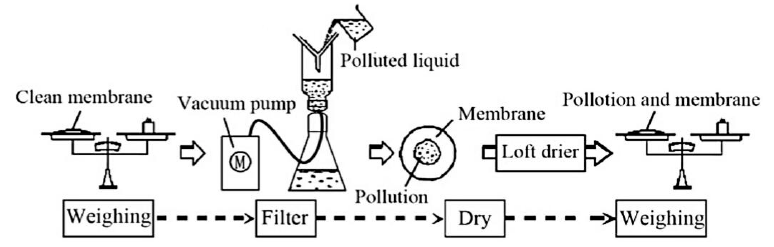
Figure 3. The measuring method of contamination.